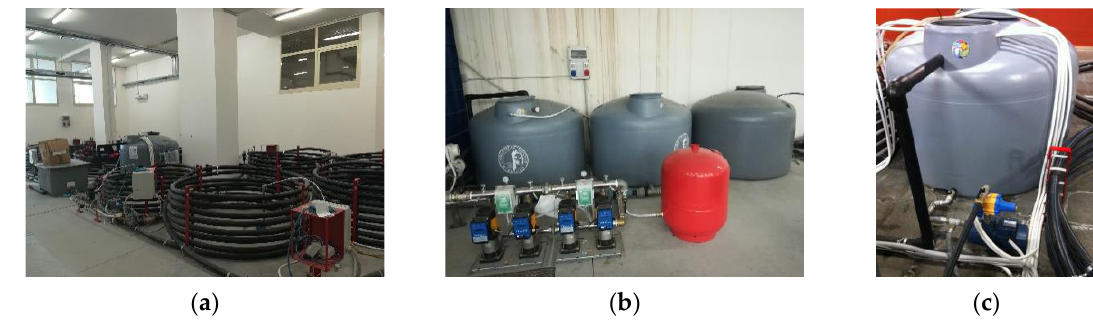
Figure 2. Overview of the experimental water distribution network ( a ), pumping system ( b ), and recirculation system ( c